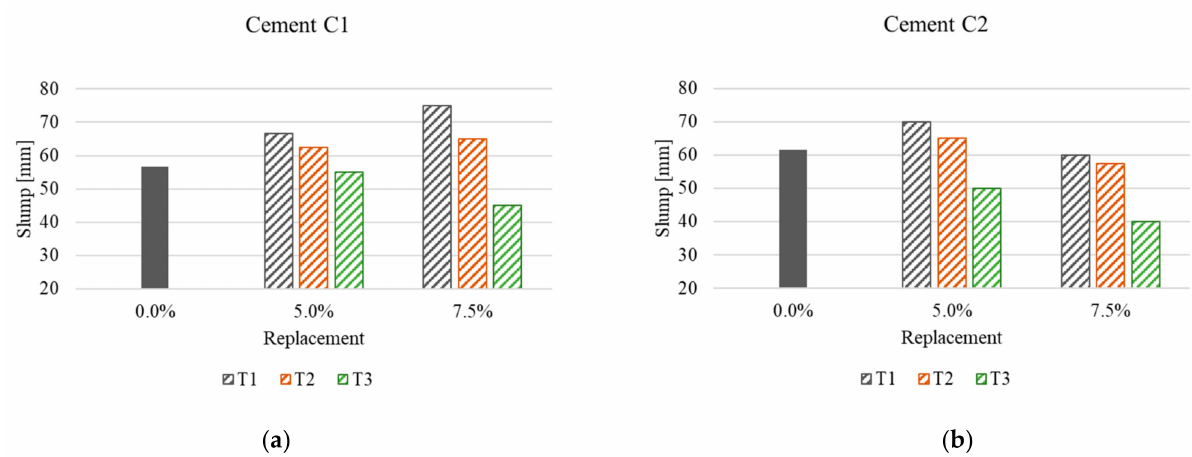
Figure 8. Mortar cone slump with addition of untreated rubber, at 5% and 7.5% replacement: ( a ) cement C1; ( b ) cement C2.